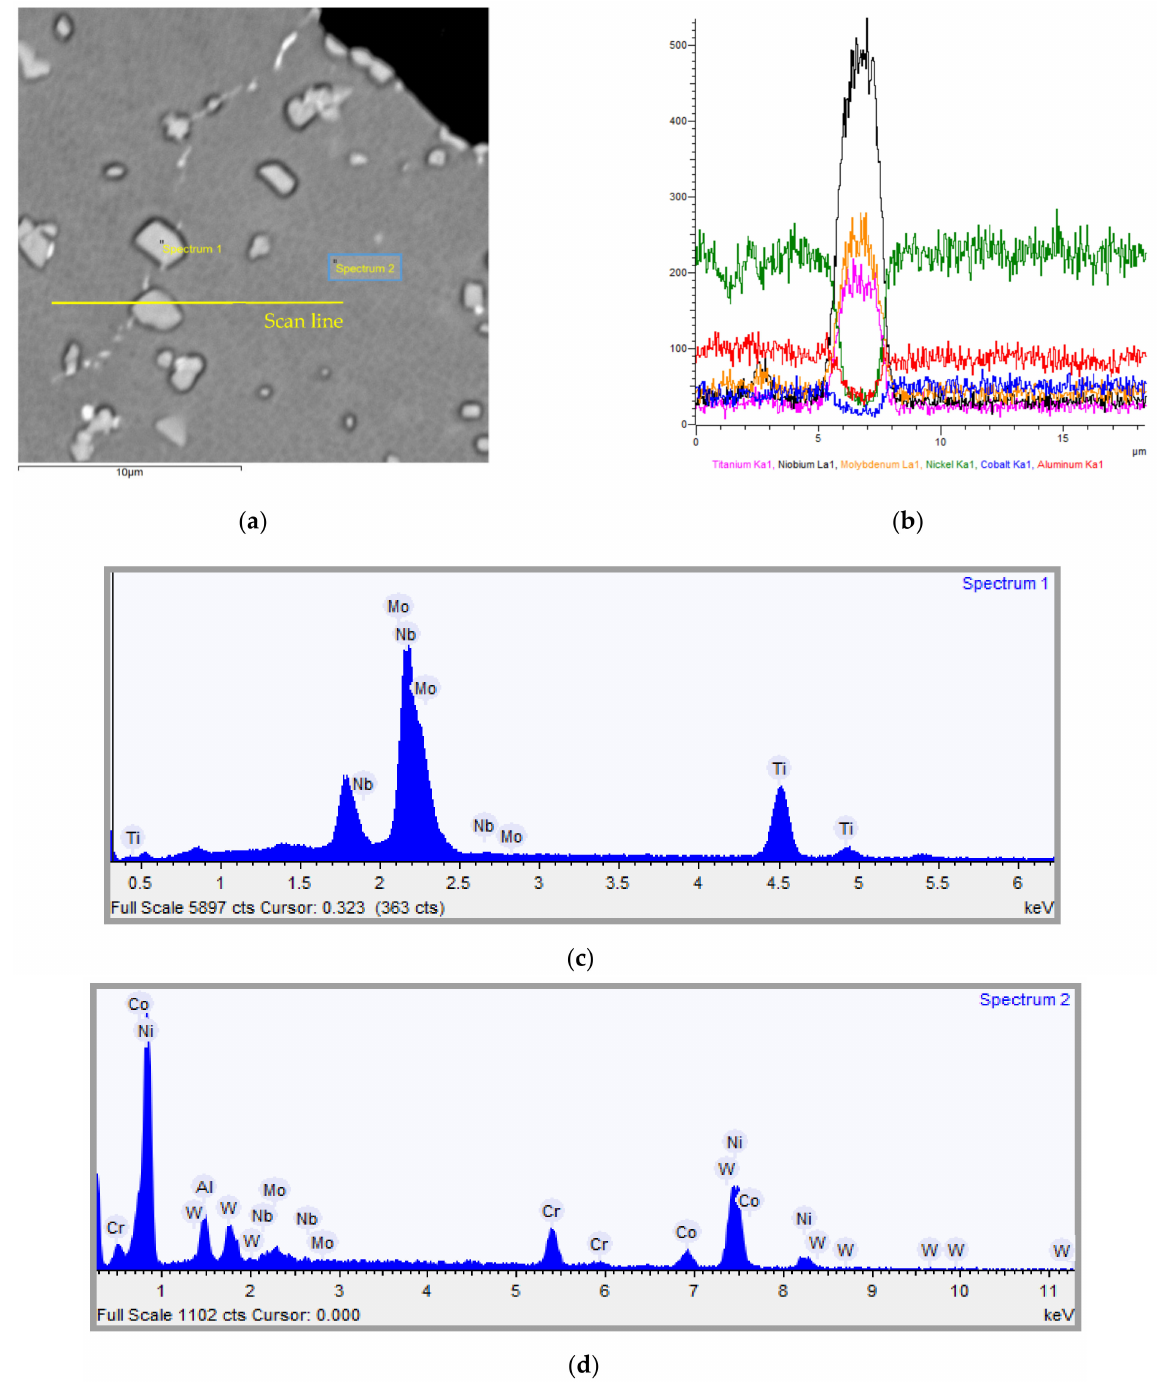
Figure 5. SEM analysis of alloying elements in a composite’s matrix: ( a ) SEM: microstructure of the